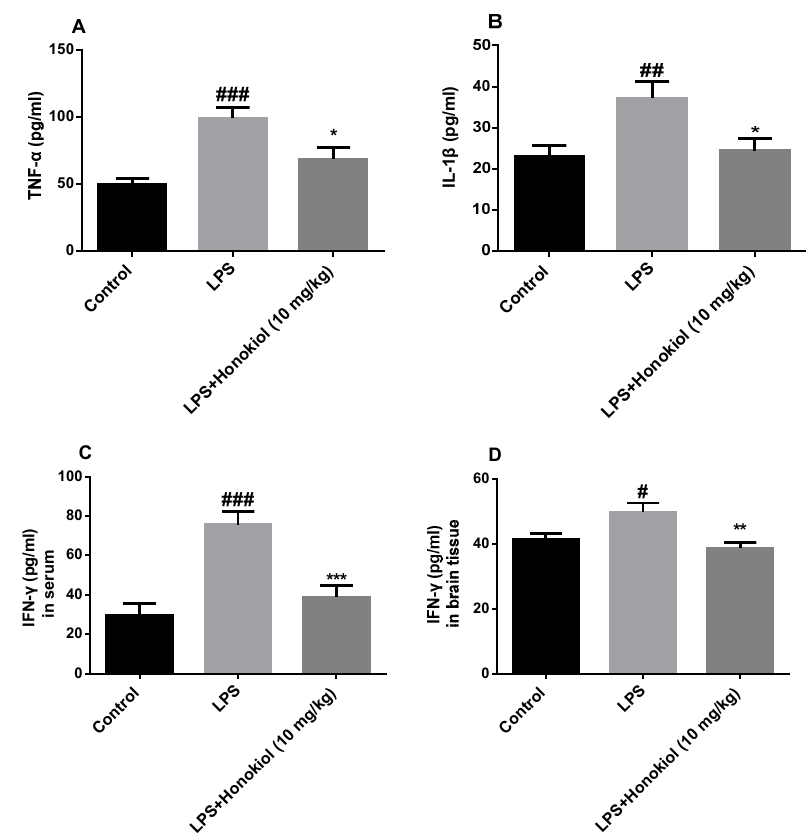
Figure 3. The e ff ects of honokiol on proinflammatory cytokines in serum and in brain tissue. Serum: ( A ) tumor necrosis factor α (TNF- α ), ( B ) interleukin 1 β (IL-1 β ), and ( C ) interferon γ (IFN- γ ); brain tissue: ( D ) IFN- γ . Data are expressed as mean ± SEM ( n = 9). ### p < 0.001, ## p < 0.01, # p < 0.05 LPS vs. control; *** p < 0.001, ** p < 0.01, * p < 0.05 LPS + Honokiol vs. LPS.